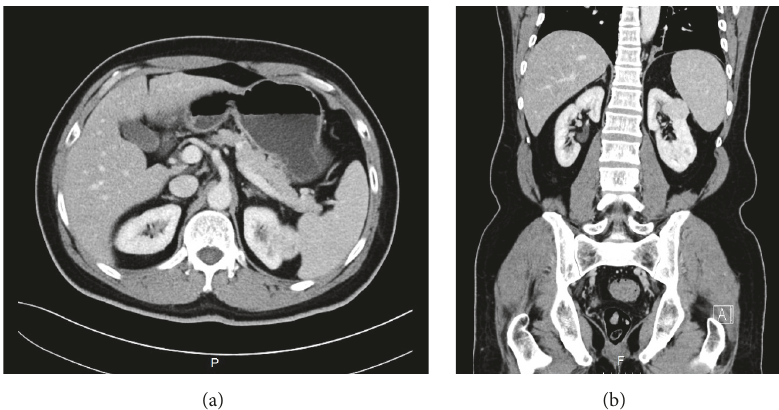
Figure 1: Computed tomography (CT) scan of the abdomen. (a) Axial section and (b) coronal section showing a well-defined heterogeneous lesion measuring 2 × 1.5 cm located at the posterolateral upper pole of the left kidney, most likely arising from kidney